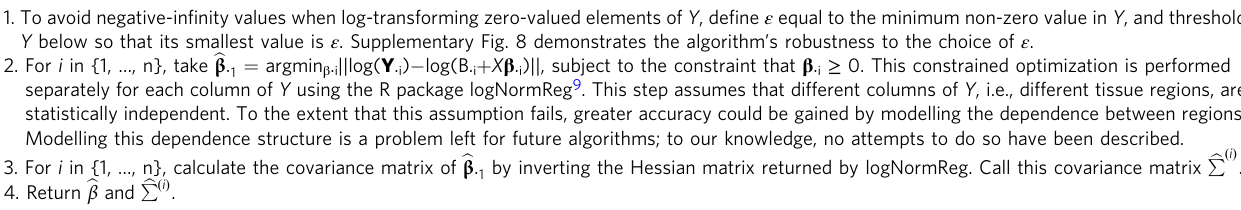
Box 1 | Log-normal deconvolution